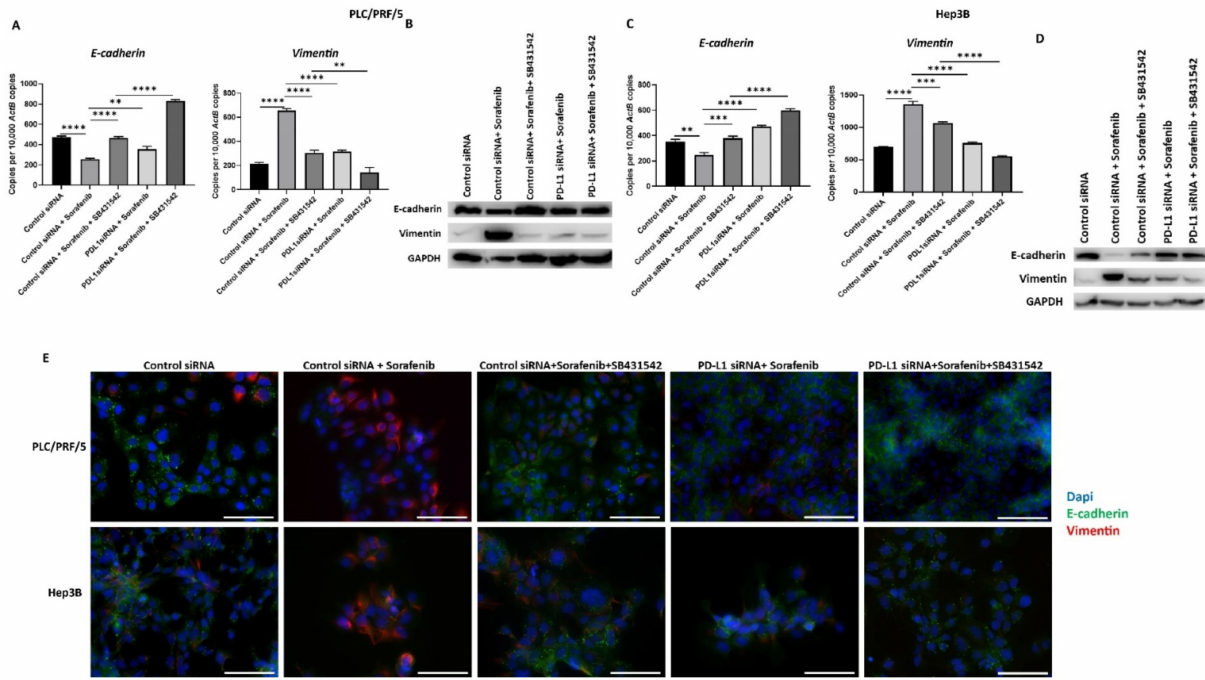
Figure 10. Combination treatment of Sorafenib with PD-L1 knockdown and SB431542 can reverse Sorafenib-driven EMT in HCC cells. Combination treatment of Sorafenib with PD-L1 knockdown and SB431542 elevated E-cadherin and downregulated Vimentin in PLC/PRF/5 cells, as demonstrated by ( A ) qRT-PCR and ( B ) western blot analysis. GAPDH was used as the loading control. Similar combination treatment of Sorafenib with PD-L1 knockdown and SB431542 resulted in upregulation of E-cadherin and downregulation of Vimentin in Hep3B cells, as demonstrated by ( C ) qRT-PCR and ( D ) western blot analysis. GAPDH was used as the loading control. ( E ) Fluorescence microscopy revealed upregulation of E-cadherin and downregulation of Vimentin in both PLC/PRF/5 and Hep3B cells following combination treatment of Sorafenib with PD-L1 knockdown and SB431542 (scale bar = 200 µ m) ( n = 3, ** p < 0.01, *** p < 0.005, **** p <